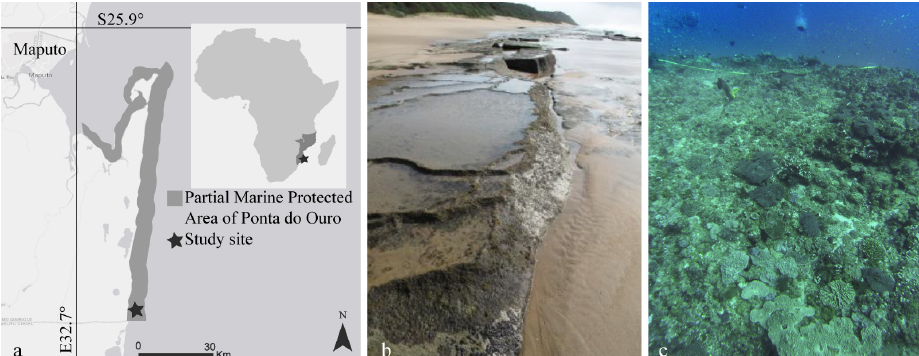
Figure 1. ( a ) Location of the study site in the Partial Marine Protected Area of Ponta do Ouro (Mozambique); ( b ) detailed image showing the fossils dune outcrops along the sandy littoral; ( c ) detailed image showing the submerged outcrops at the dive site.